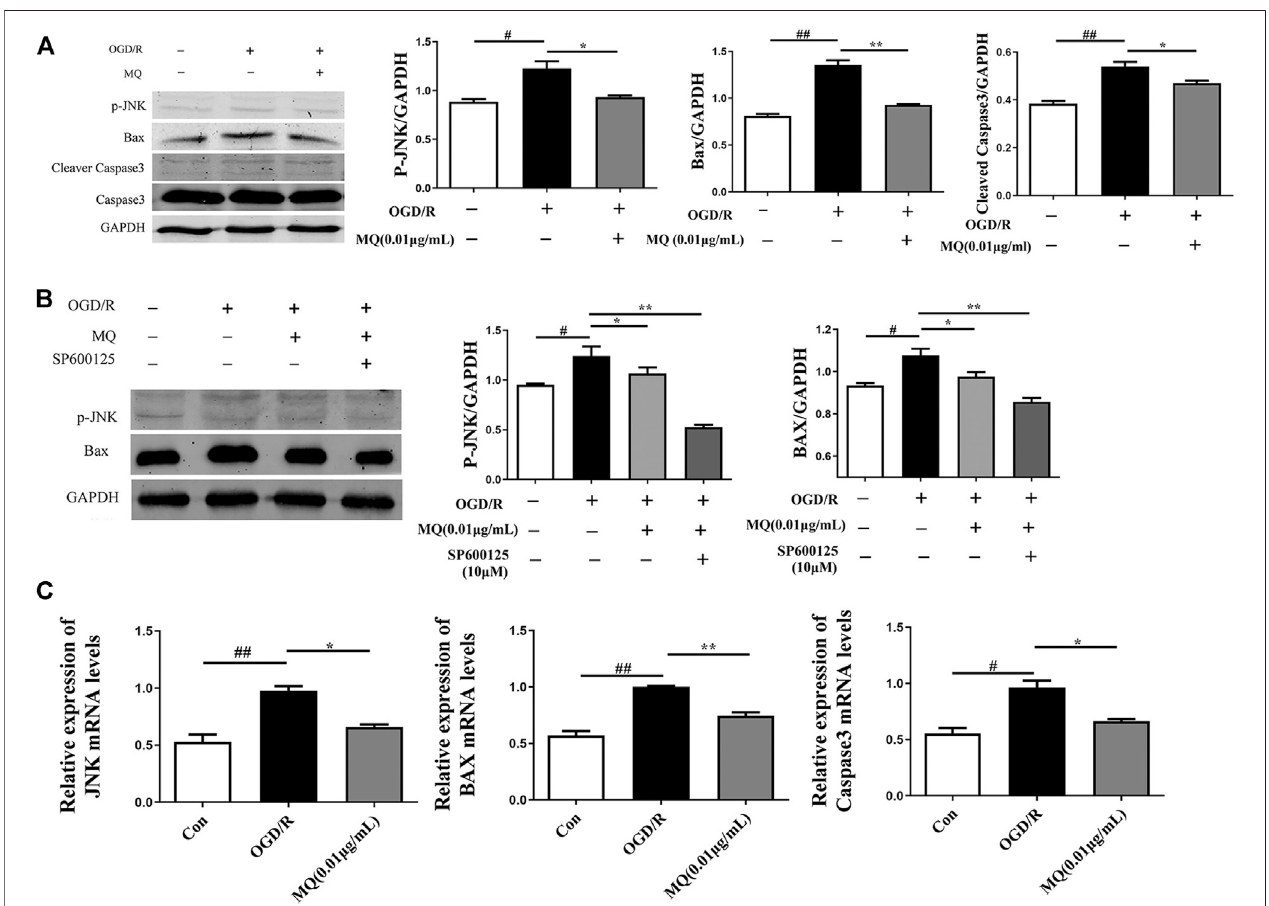
FIGURE6| MQdecreasedcellapoptosis viap-JNK/Bax pathway. (A) Proteinexpression ofp-JNK, Bax,andcleaved Caspase3levels inPC12cells, asexamined by Western blot, (B) representative protein expression of p-JNK and Bax treated with JNK inhibitor (SP600125), as examined by Western blot, (C) Effects of MQ on the mRNA levels of JNK , Bax , and Caspase3 after OGD/R. # p < 0.05, ## p < 0.01, OGD/R group vs. Con group; * p < 0.05, ** p < 0.01, OGD/R group vs. MQ 0.01 μ g/mL group; n (cid:2)